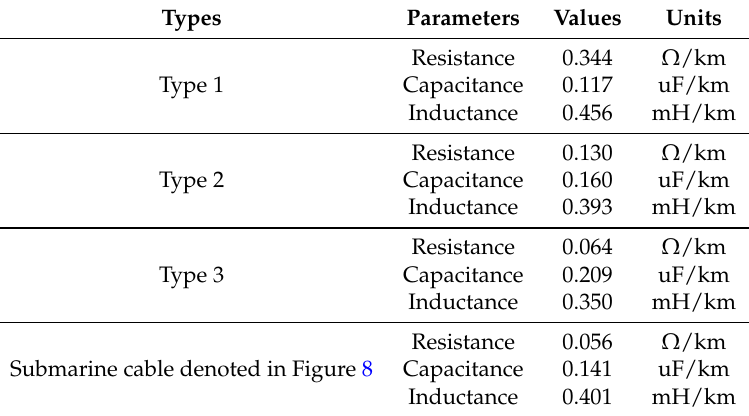
Table A3. Parameters of the cable